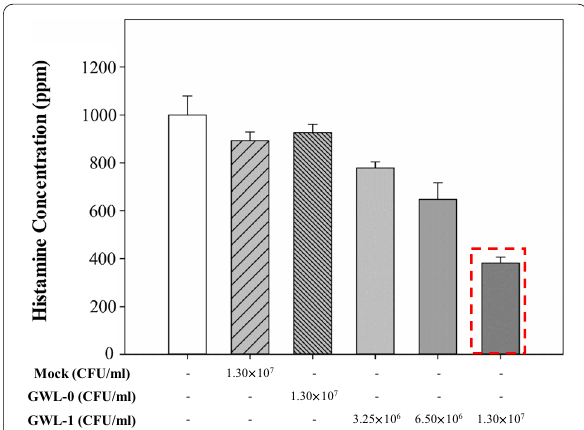
Fig. 3 Histamine inhibitory ability according to the cell concentration. GWL‑1 cells were tested by the cell concentration.